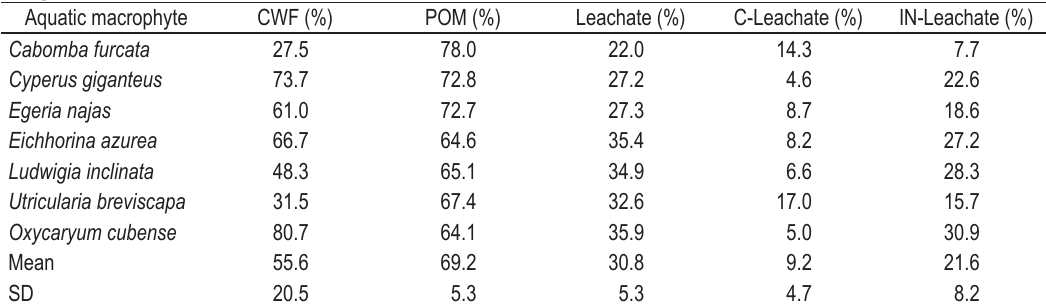
Table 1. Chemical composition of aquatic macrophytes tissues. Where: CWF = cell wall fraction; POM = particu- late organic matter; Leachate = leachate potential; C-leachate = organic carbon content of leachate; IN-Leachate = inorganic content of leachate.